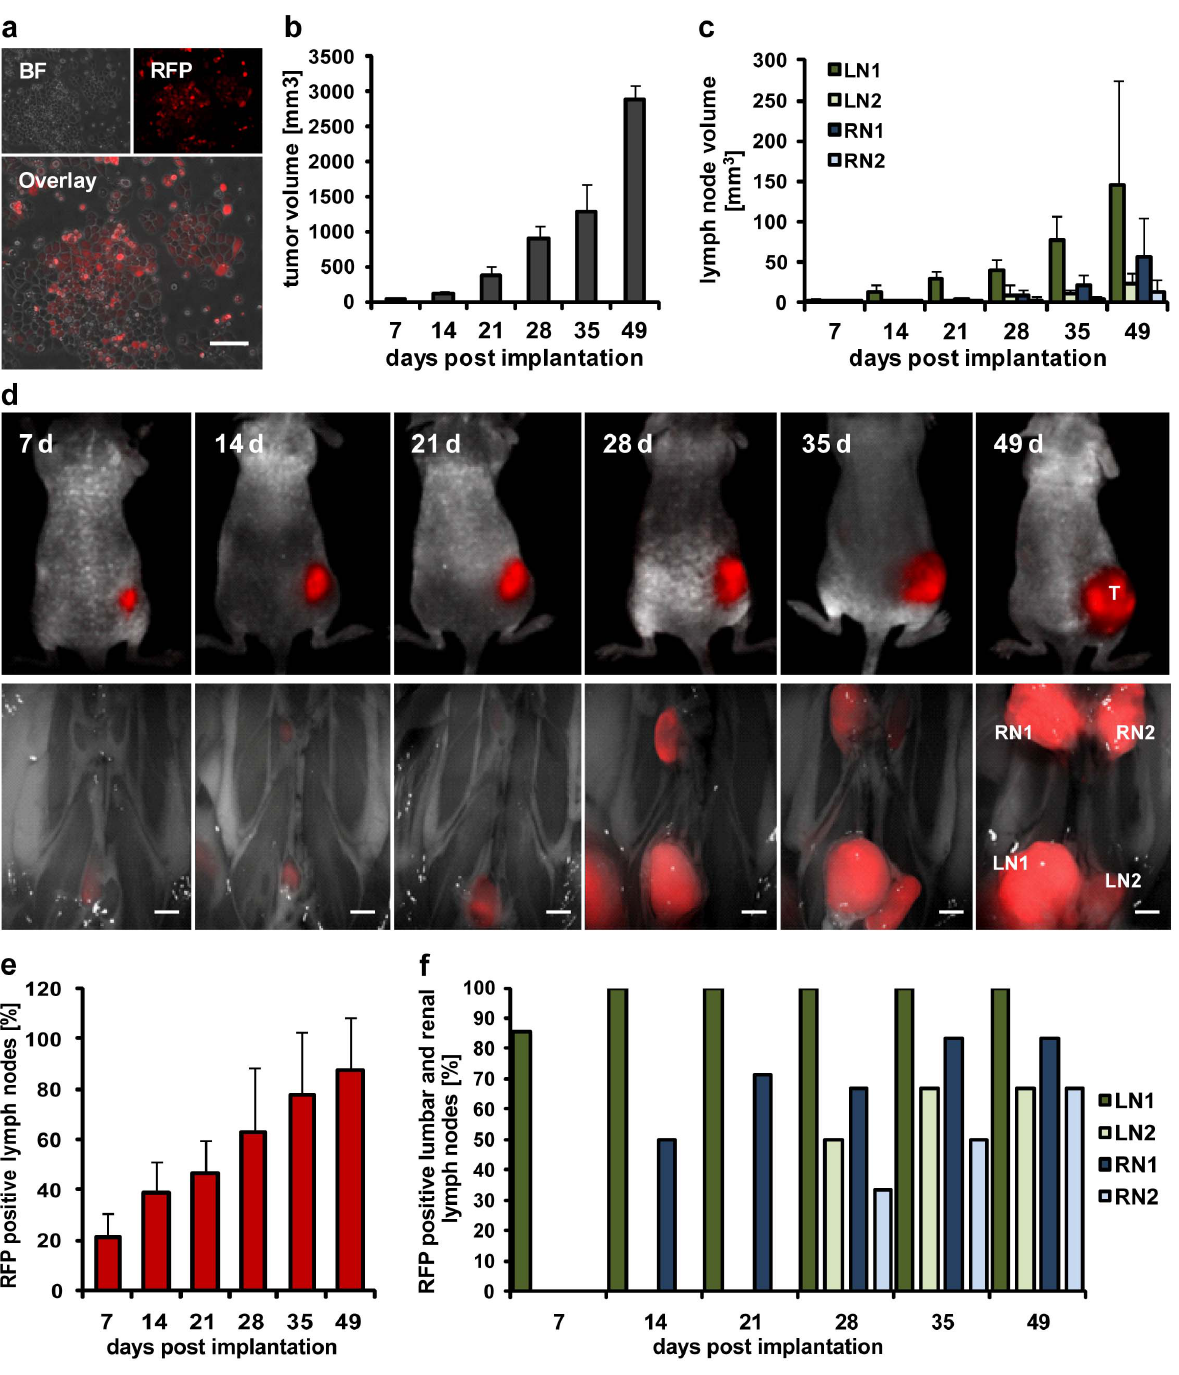
Figure 1. Formation of tumors and lymph node metastases after subcutaneous implantation of 5 6 10 6 C33A-RFP cells. Tumors and lymph nodes of six to seven mice per time point were analyzed (7 and 21 dpti: n=7; 14, 28, 35 and 49 dpti: n=6). a Bright field (BF), RFP and overlay images of C33A-RFP cells, scale bar represents 100 m m. b Time curve of C33A-RFP tumor growth. c Volume of lumbar and renal lymph nodes over time. d Representative images of tumors (upper row) and corresponding lymph nodes (lower row) of C33A-RFP tumor-bearing mice at the indicated days post tumor cell implantation. Images of tumors (T) were taken of living mice using the Maestro EX Imaging System. Imaging of lumbar (LN1, LN2) and renal (RN1, RN2) lymph node metastases in the abdomen of tumor-bearing mice was performed post mortem , after opening the abdomen and removing organs. Scale bars represent 2 mm. e Percentage of all lymph nodes positive for RFP over time. f Percentage of LN1, LN2, RN1 and RN2, respectively, positive for RFP per time point. doi:10.1371/journal.pone.0098533.g001 lungs of C33A-RFP tumor-bearing mice which usually is the first no lung was found to be positive for RFP, whereas at day 35 three organ to get metastasized in case of metastatic spread via the out of six and at day 49 five out of six lungs were tested positive for hematogenous route. Up to day 28 post tumor cell implantation RFP spots (Fig. 2d).